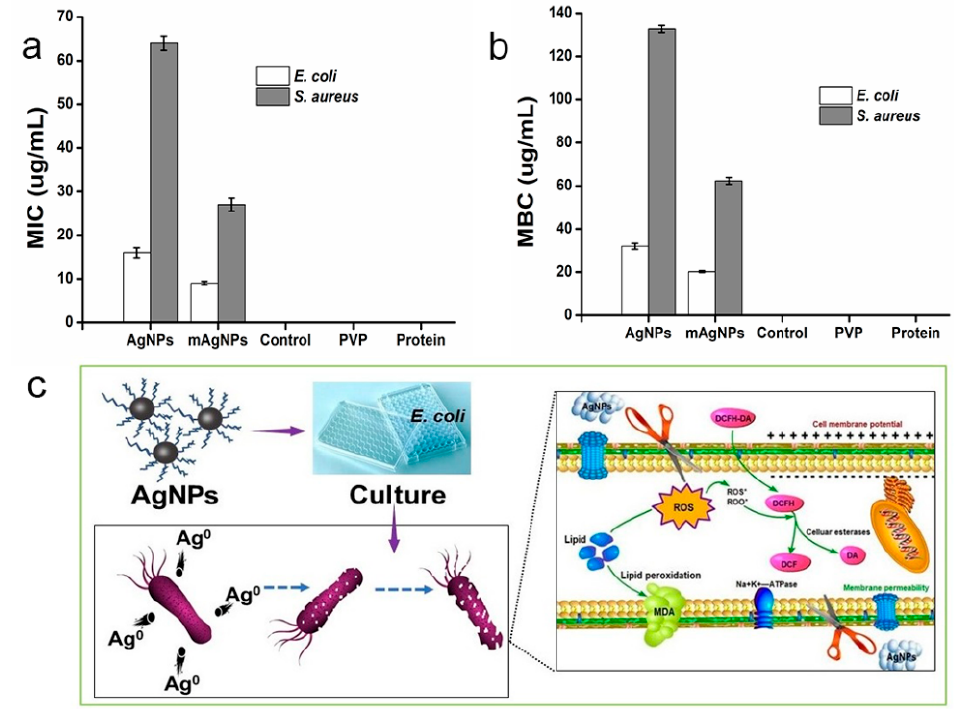
Figure 3. MICs ( a ) and MBCs ( b ) of AgNPs in E. coli and S. aureus ; ( c ) a possible schematic showing the antibacterial mechanism of AgNPs against E. coli . mAgNPs indicated that the AgNPs were synthesized with the Ag + /PVP mass ratio of 1:1.